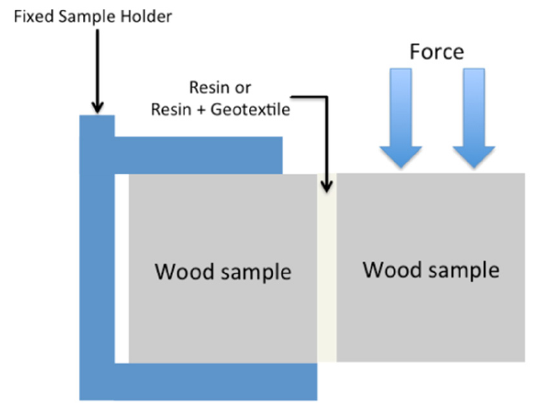
Figure 5. Schematic diagram of the experimental setup to measure the adhesion between the wood and the coating